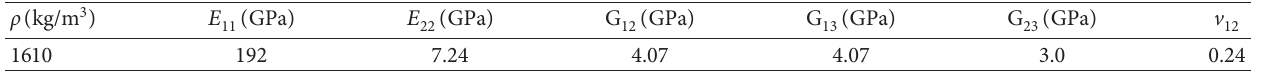
Figure 2: The natural frequency of a cylindrical composite thin-walled shaft with SMA versus rotating speed ( θ � 30 ° , T � 50 ° C,Vs � 0 . 36, ε 0 � 0.067). Table 1: Mechanical properties of composite material [1].